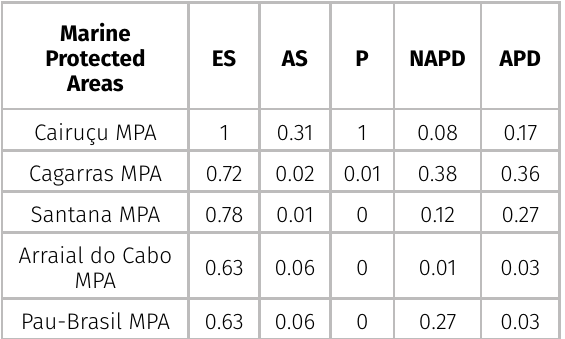
Table II. Results for all the analyzed factors and environmental similarity. ES: environmental similarity between the analyzed MPAs and the donor area; AS: available substrate; P: proximity to the donor area; NAPD: non-anchored platforms and drill ships; APD: anchored platforms and drill ships.